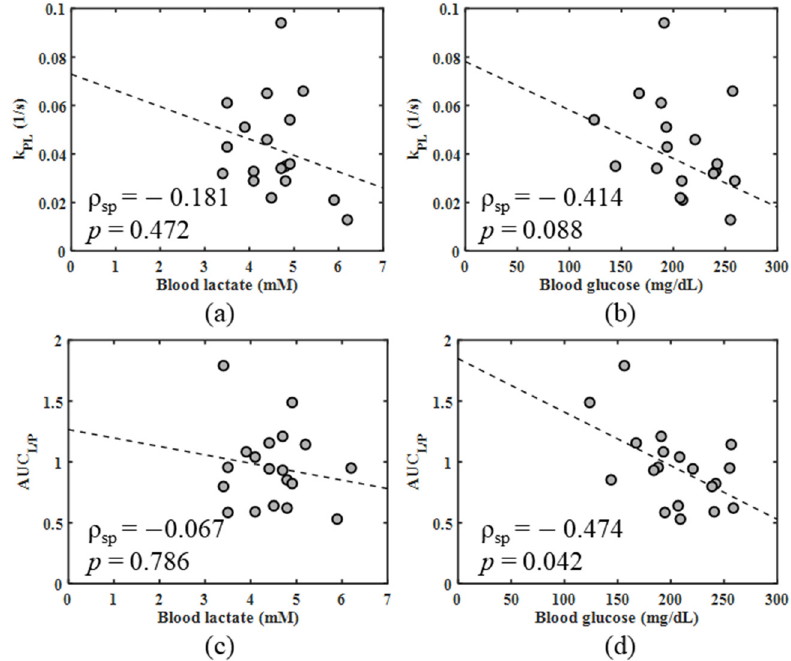
Figure 5. Spearman correlation plots comparing k PL with blood ( a ) lactate and ( b ) glucose levels, and AUC L/P with blood ( c ) lactate and ( d ) glucose levels. Spearman correlation coefficients ( ρ sp ) and p -values are listed on the plots.